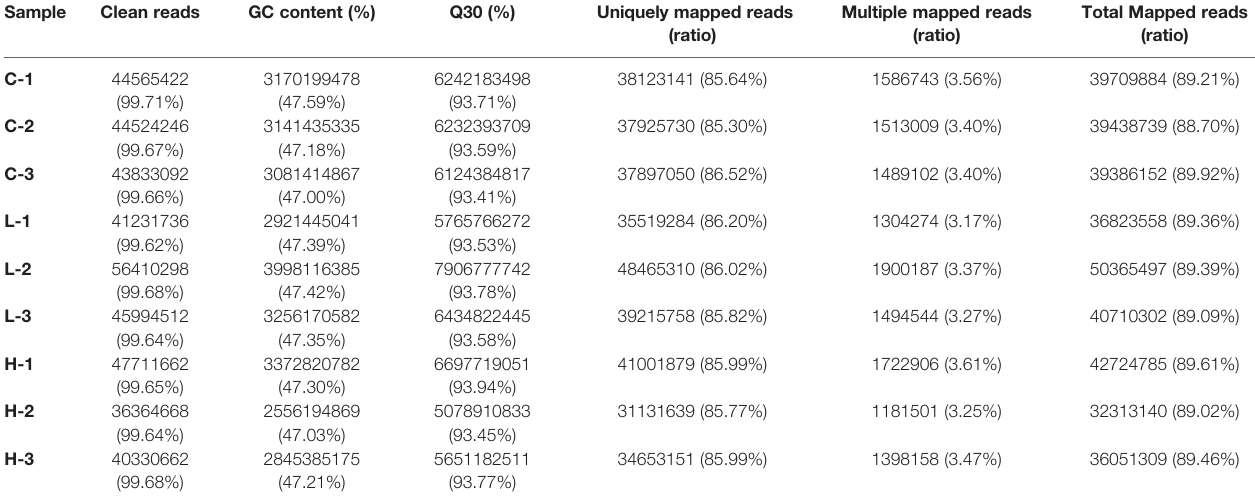
TABLE 2 | Summary statistics of transcriptome